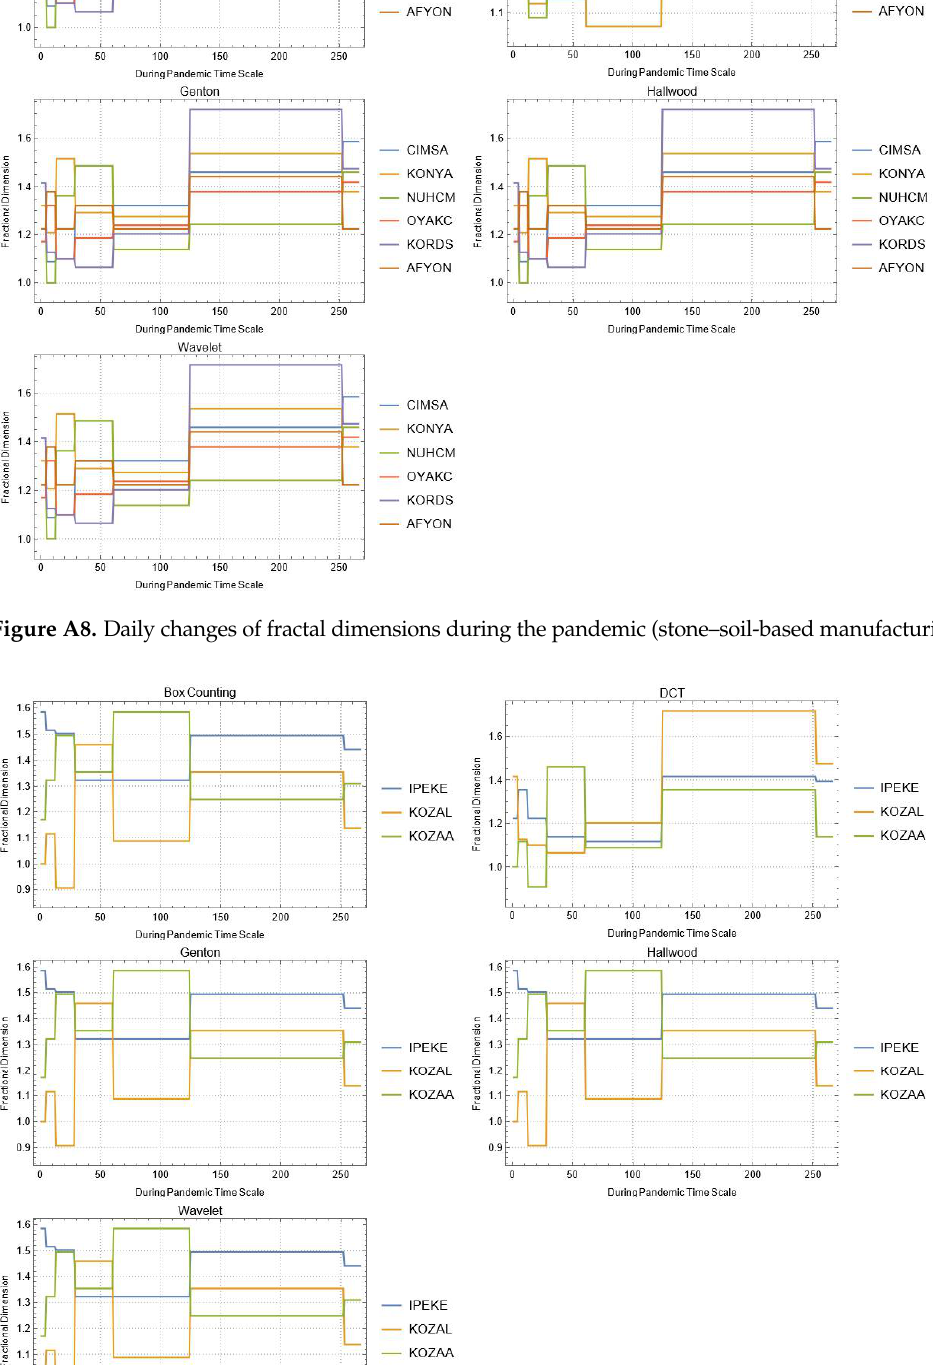
Figure A9. Daily changes of fractal dimensions during the pandemic (mining).